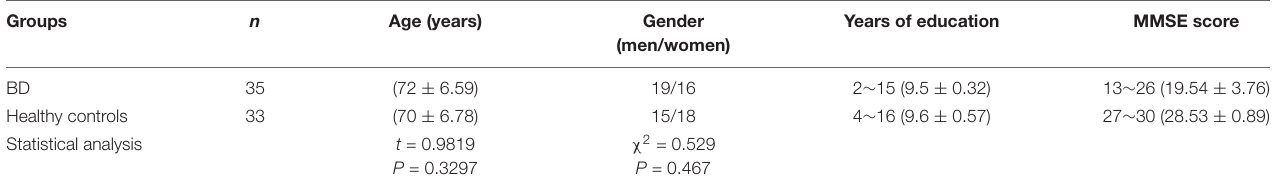
TABLE 1 | Clinical information about comparison of age and gender between the patients with Binswanger’s disease (BD) and healthy controls using t -test and chi-square test, respectively.